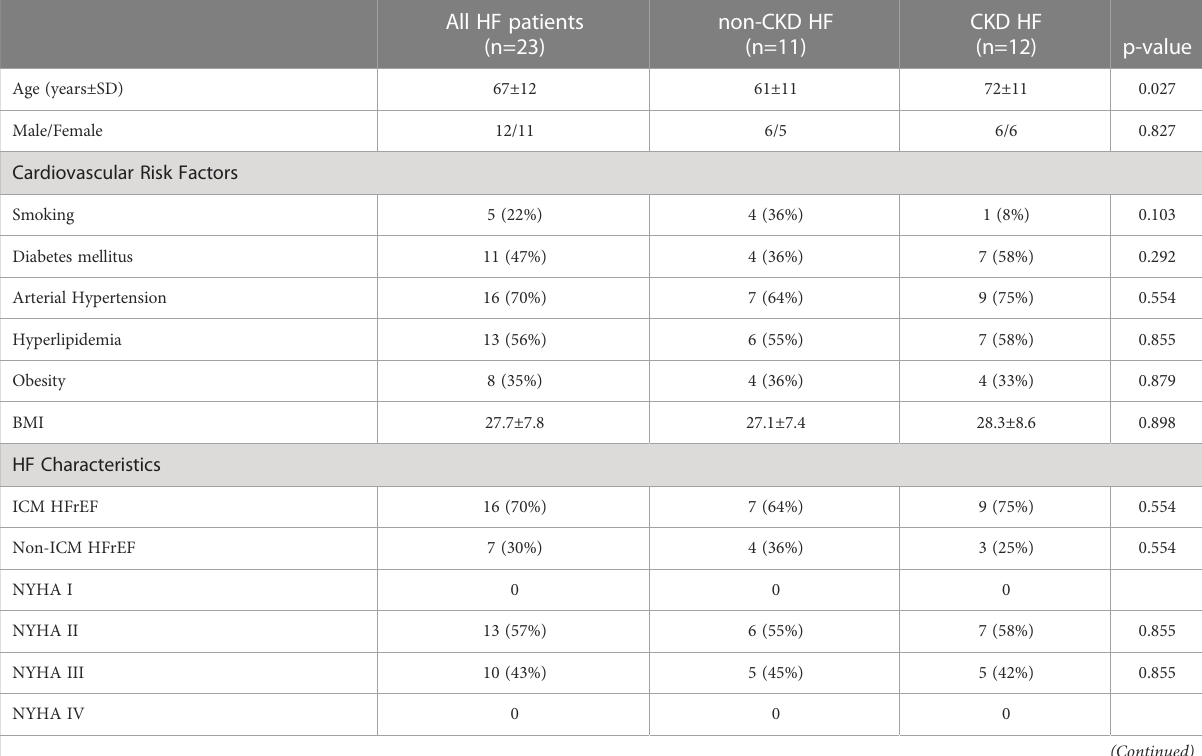
TABLE 1 Summary of patient